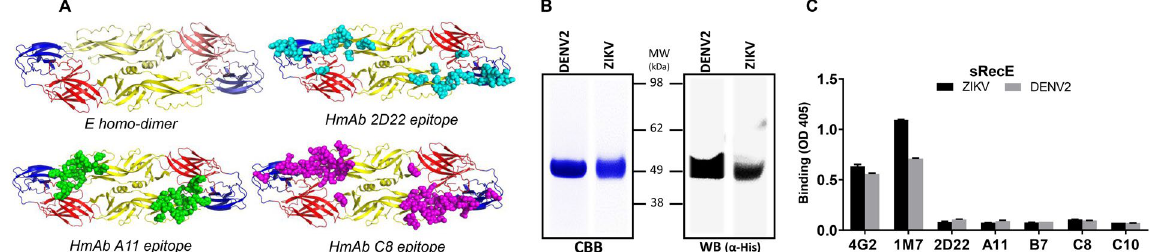
Figure 1. DENV2 and ZIKV sRecE expression and characterization. ( A ) The flavivirus E protein consists of three beta-barrel domains designated domains I (red), II (yellow) and III (blue), with the native protein forming a head-to-tail homo-dimer. The quaternary epitopes recognized by human dimer-dependent Mabs 2D22 (cyan), A11 (green) and C8 (magenta) are indicated 22, 35 . ( B ) DENV and ZIKV sRecE expression was analyzed by Western Blot (anti-His mAbs), CBB ( C ) and by ELISA using 4G2, 1M7, 2D22, A11, B7 (EDE2), C8 and C10 (EDE1) mAbs.